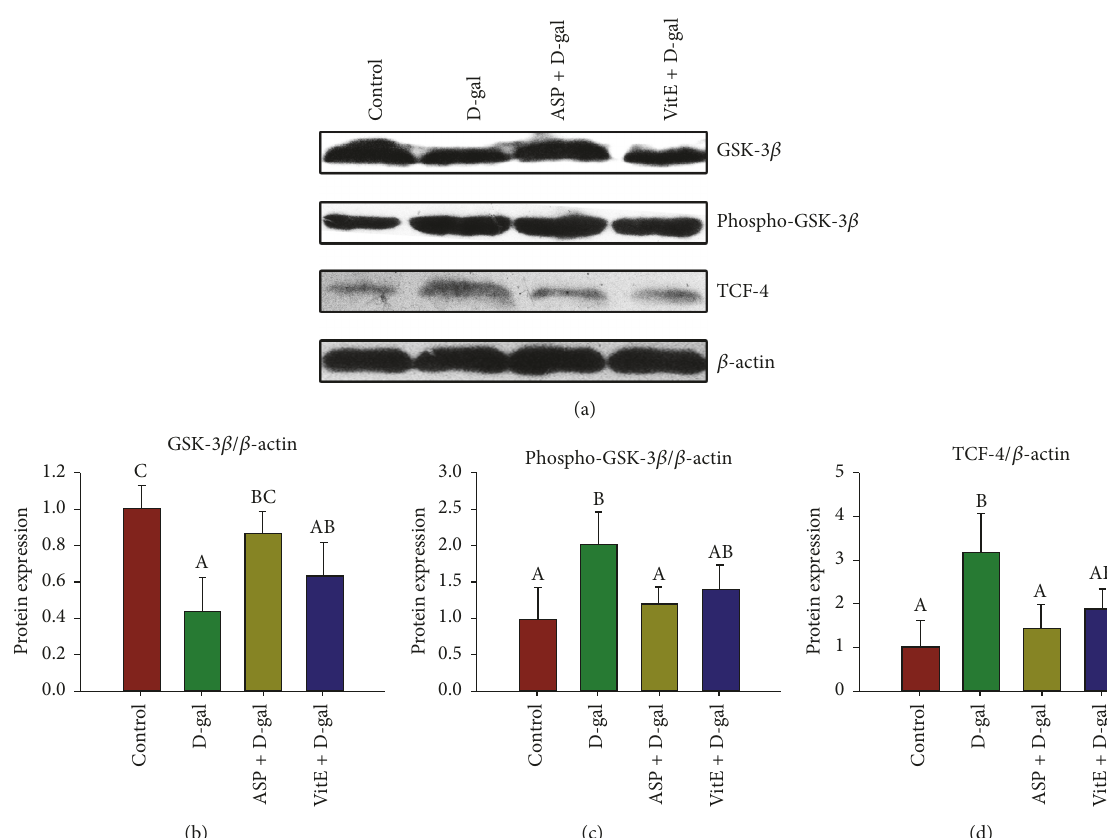
Figure 5: Effect of ASP on Wnt/ 𝛽 -catenin signaling mediators of Sca-1 + HSC/HPCs in D-gal- induced aging mice. The Sca-1+ HSC/HPCs were collected after the treatment. (a) GSK-3 𝛽 , Ser9-phosphorylated GSK-3 𝛽 and TCF-4 protein expressions by Western blot. 𝛽 -actin was usedastheinternalcontrol.(b)TherelativeproteinexpressionofGSK-3 𝛽 .(c)TherelativeproteinexpressionofSer9-phosphorylatedGSK-3 𝛽 . (d) The relative protein expression of TCF-4. Different letters: 𝑃 < 0.05